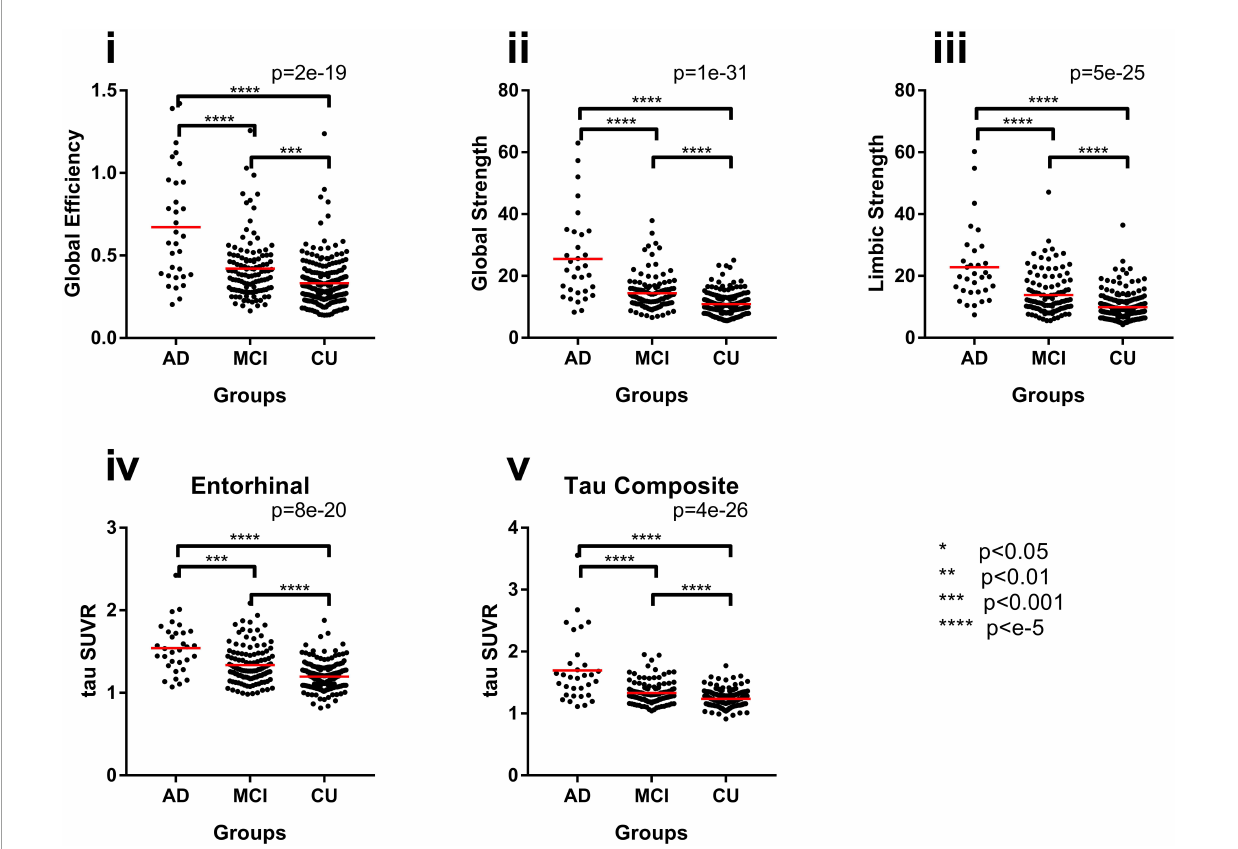
FIGURE4 Group differences with network measures for the original FTP networks, (i) global efficiency, (ii) global strength,and (iii) limbic strength, and common regional measures, (iv) entorhinal SUVR and (v) tau composite SUVR between AD, MCI, and CU subjects. * p < 0.05, ** p < 0.1, *** p < 0.002, **** p <